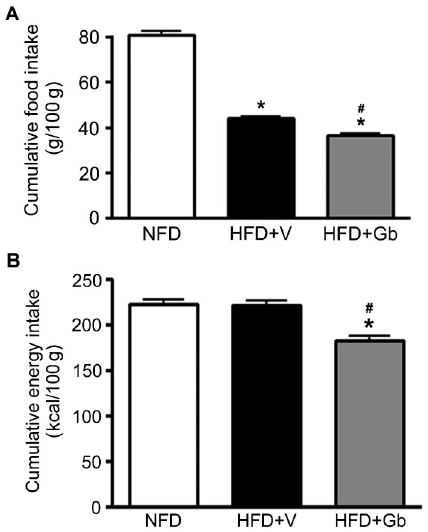
Figure 3. A , Cumulative food intake (g) and B , cumulative energy intake (kcal/100 g) of normal fat diet (NFD; n=12), high-fat diet plus vehicle (HFD++V; n=25), and high-fat diet plus Ginkgo biloba (HFD++Gb; n=20) groups during phytotherapy treatment. *P , 0.05 vs NFD, # P , 0.05 vs HFD++V (one-way ANOVA followed by the Tukey HSD test).